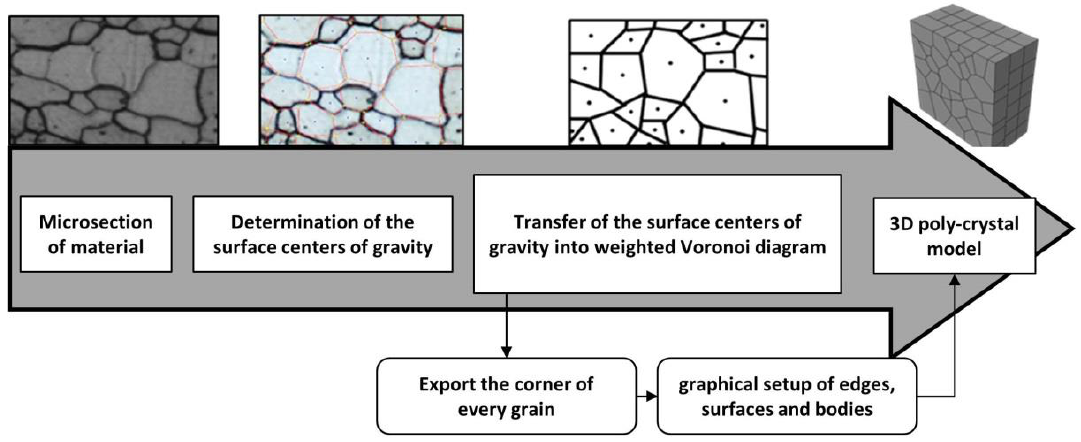
Figure 1. Procedure for three-dimensional polycrystalline modeling.